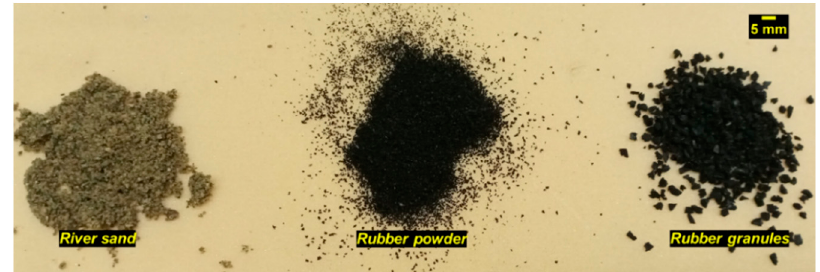
Figure 1. River sand and GWTR used in this study.